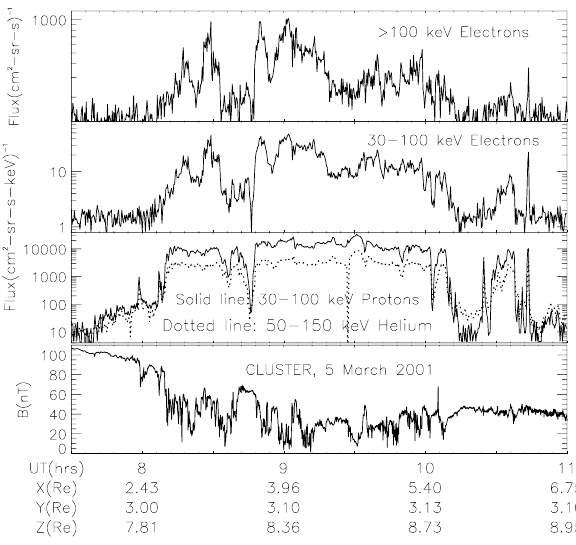
Fig. 1. POLAR measurement for the 0.52–1.15MeV Helium flux versus time (a) at 04:00–09:30UT on 10 September 1996, and the corresponding variations of the geomagnetic field (b) , followed by the distance of POLAR from the Earth (in R E ), the magnetic lati- tude (MLAT), and the magnetic local time (MLT).